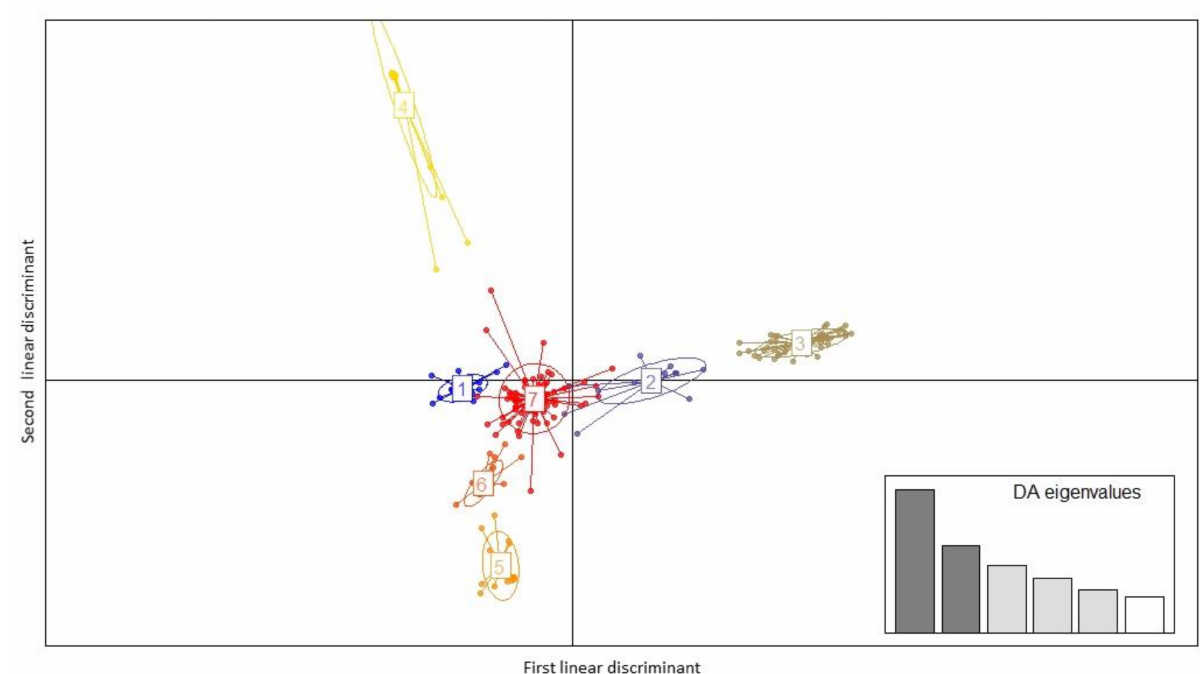
Figure 2. DAPC results for the 265 accessions of Triticum turgidum L. used in the analysis. The first two linear discriminants (LDs) are represented by the axes. Each circle with the relative number and color represents one identified cluster, and each dot represents one accession.